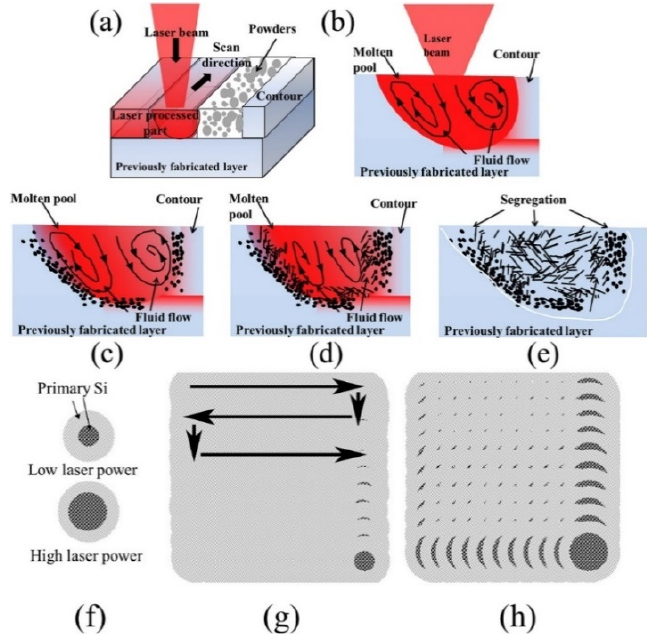
Figure 28. Schematic illustration of segregation mechanism of an SLM-processed hypereutectic Al-50Si alloy during remelting and solidification: ( a ) scanning mode, ( b – e ) solidification process, ( f ) melt pool, scanning results of single layer of samples obtained at ( g ) low and ( h ) high laser powers [152].